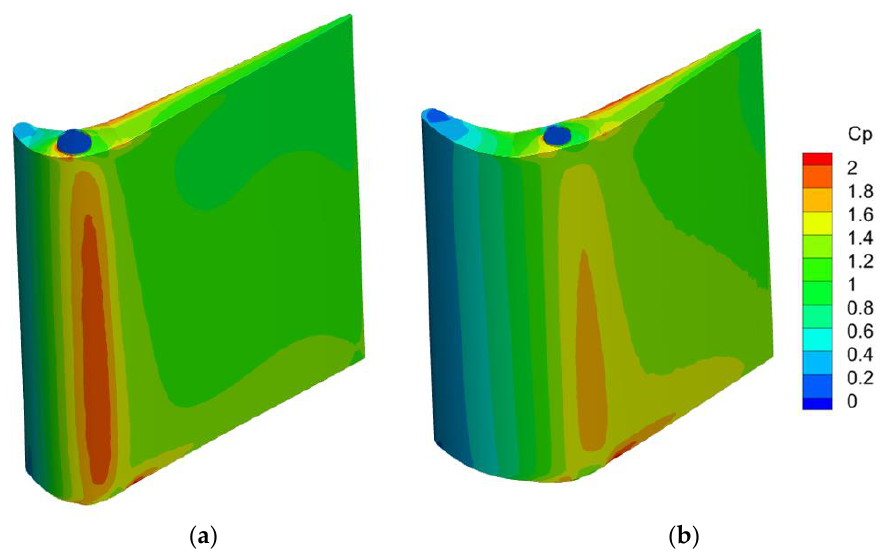
Figure 17. The cp on two typical vane surfaces, at design speed and design pressure ratio. ( a ) Front- Loaded ( b ) Aft-Loaded.